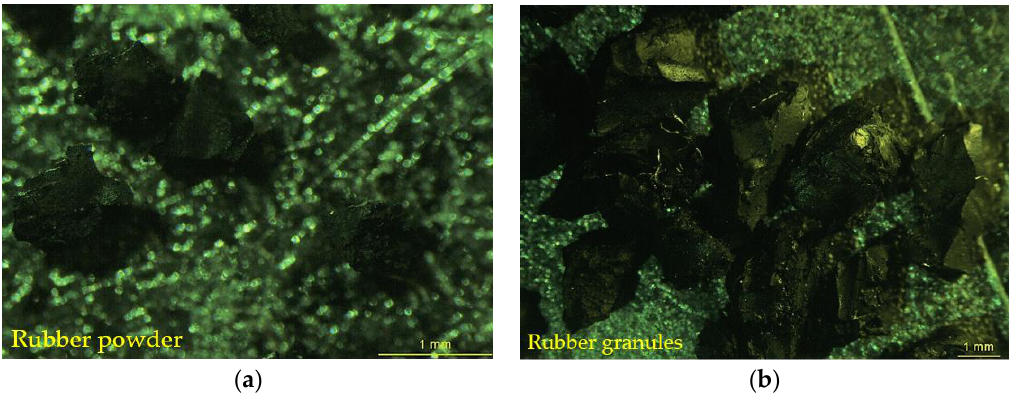
Figure 8. Stereomicrographs of GTR aggregates used in this research: rubber powder (RP) ( a ) and rubber granules (RG) ( b ).